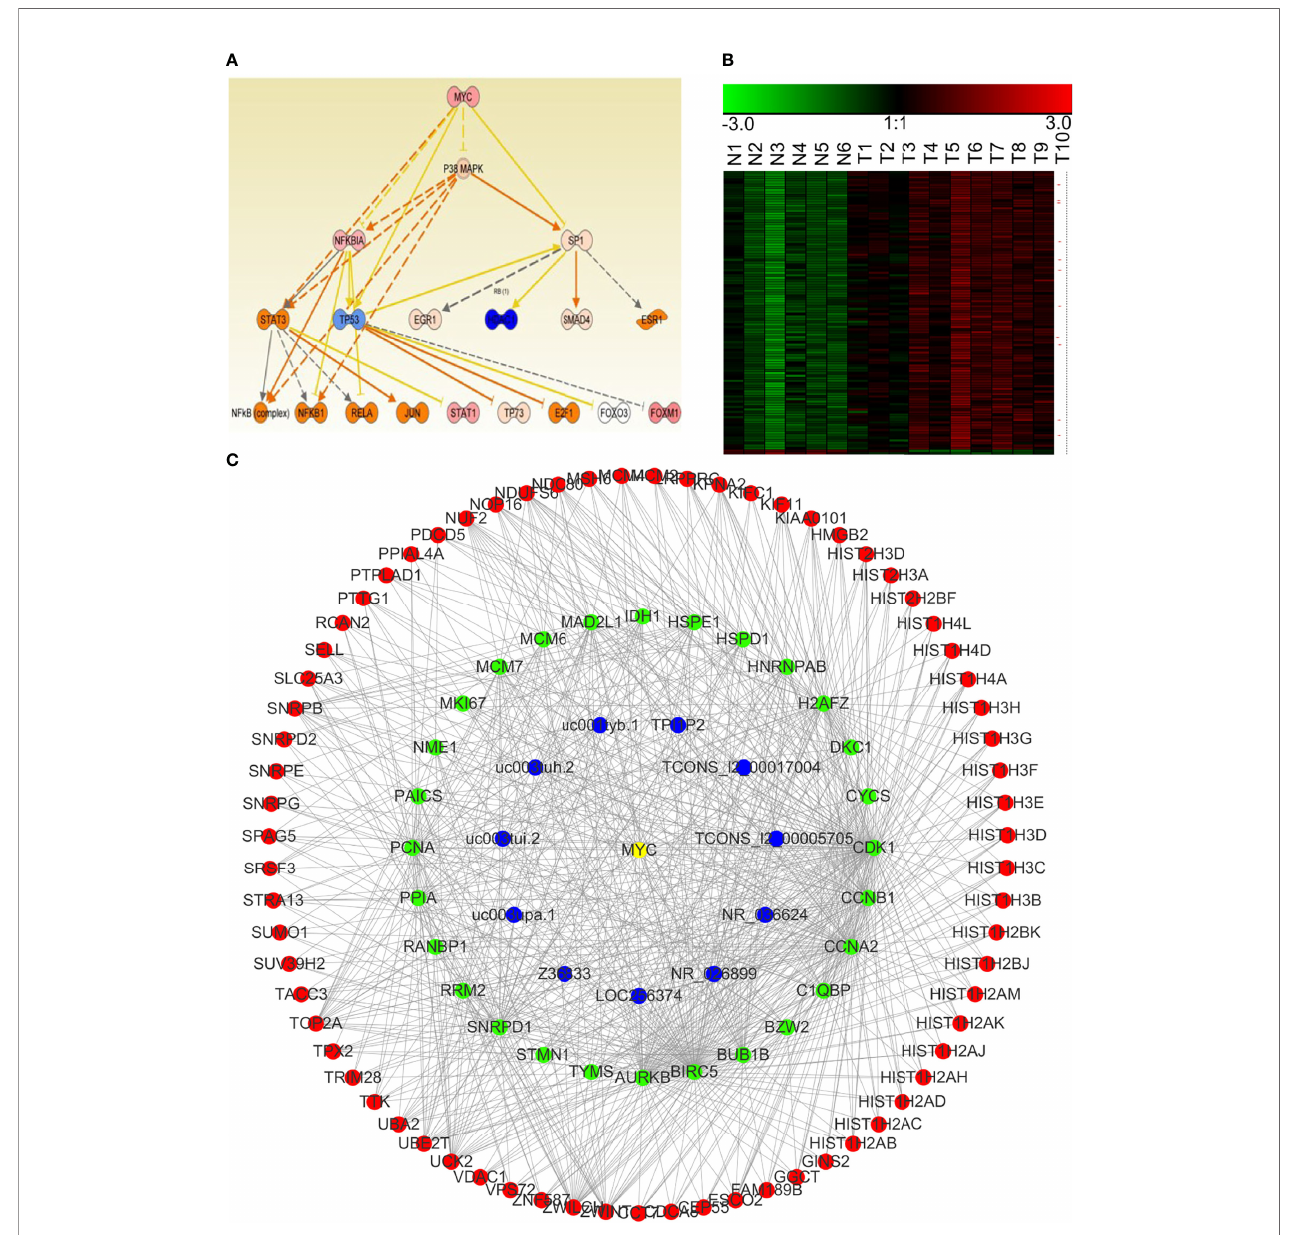
FIGURE 8 | The MYC-driven lncRNA – mRNA co-expression network module in NPC. (A) The regulatory model for MYC and the other transcription factors involved in NPC (obtained using IPA). (B) Expression of the potential mRNAs and lncRNAs downstream of MYC in NPC (red asterisk indicates lncRNAs). N, the control nasopharyngeal epithelium; T, nasopharyngeal carcinoma. (C) We generated a MYC-driven lncRNA – mRNA co-expression network module for NPC by integrating the IPA and the WGCNA